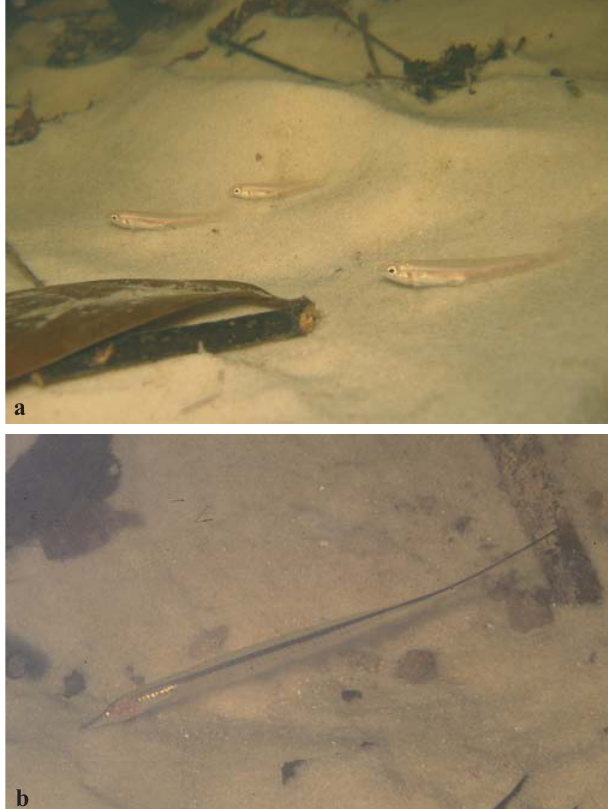
down posture while actively searching for interstitial